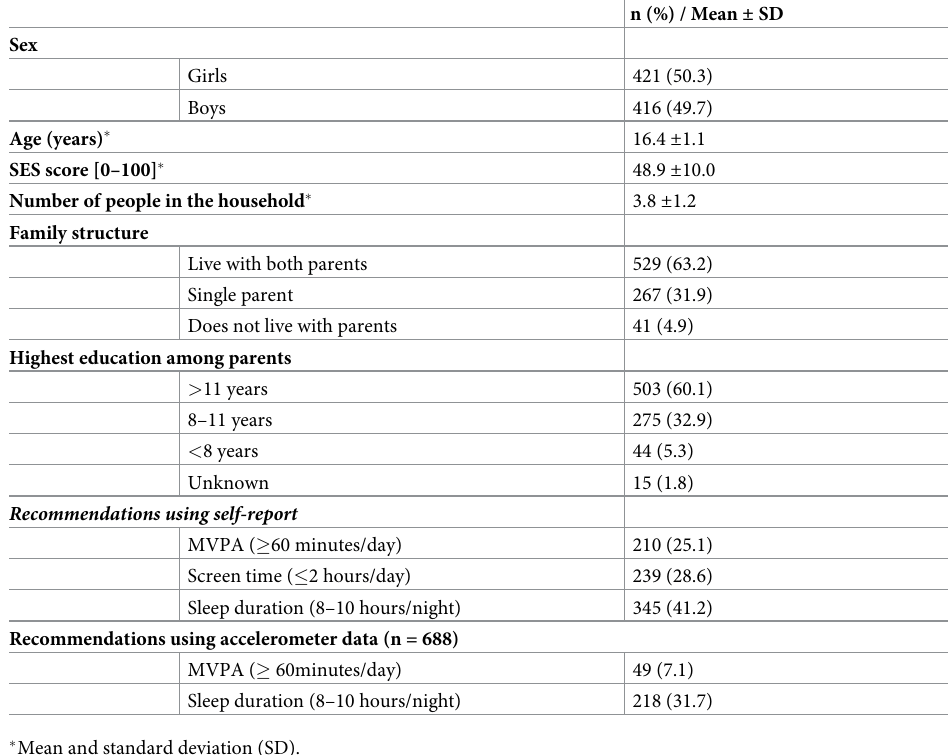
Table 1. Descriptive characteristics of the sample.